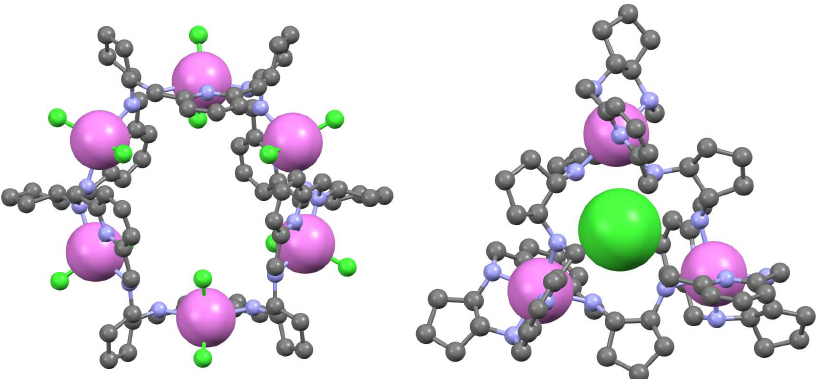
Figure 28. Molecular structures of the hexanuclear (left) and trinuclear (right) zinc(II) complexes of macrocycle 59 . Metal ions (violet) and the central chloride guest anion (green) are shown in spacefill representation, hydrogen atoms are omitted.